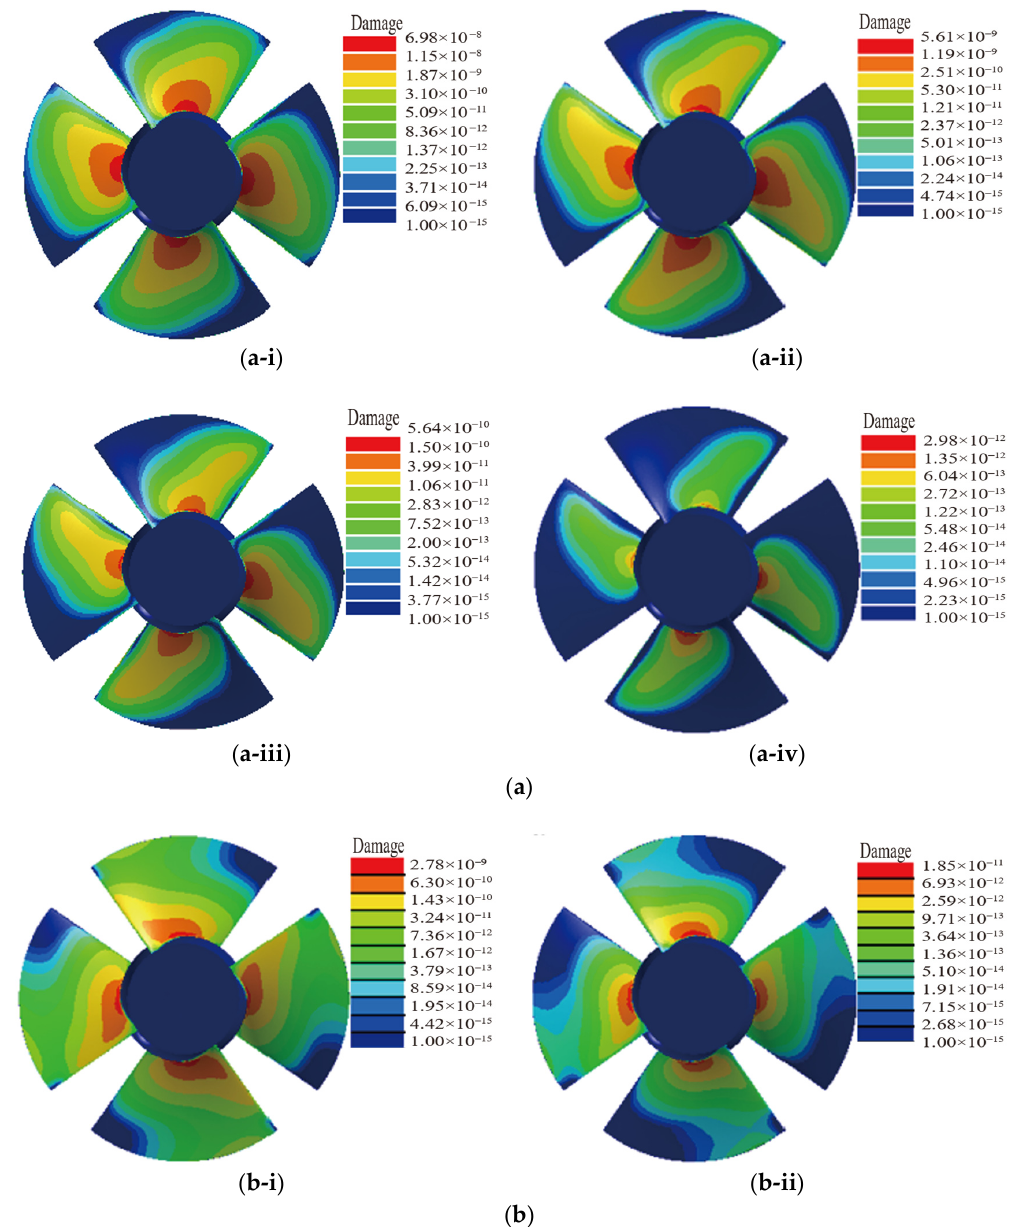
Figure 14. ( a ).Contour diagrams of blade fatigue damage under pump conditions. ( a-i ) 0.6 Q, ( a-ii ) 0.8 Q, ( a-iii ) 1.0 Q, ( a-iv ) 1.2 Q, ( b ). Contour diagrams of blade fatigue damage under turbine operating conditions. ( b-i ) 0.6 Q, ( b-ii ) 1.0